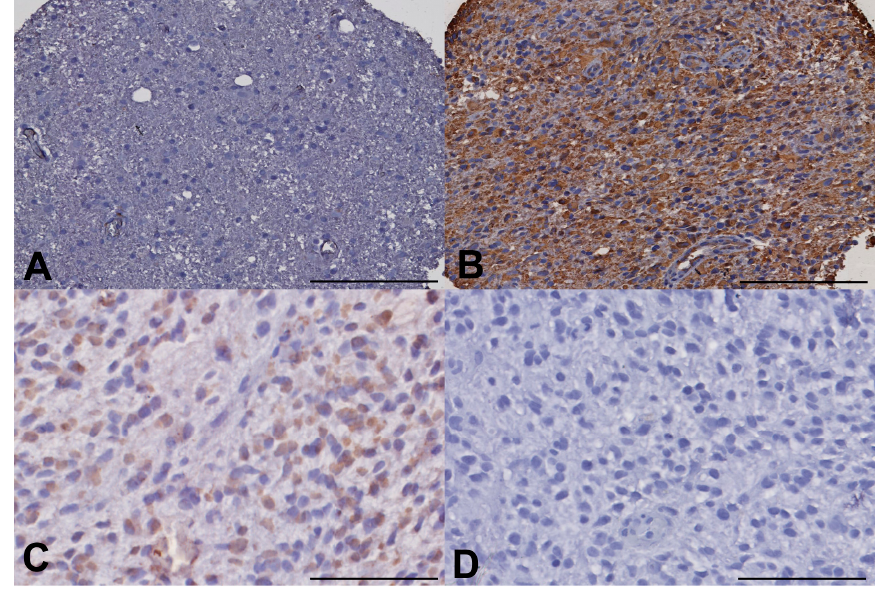
Figure 4. The GBM invasive margin exhibits reduced expression of canonical glioma stem cell markers. ( A ) Immunohistochemistry against nestin in invasive zone tissue showing low staining (23.1% +/ − 11%). ( B ) Immunohistochemistry against core tumour showing high expression of nestin (80.7% +/ − 31%). ( C ) Positive staining for ALDH1 in an invasive region of tumour (53.6% +/ − 29%). ( D ) Low levels of ALDH1 detected in the tumour core (10.3% +/ − 4%). ( A , B ) ×40, ( C , D ) ×200. Error bars ( A , B ) 100 µm; ( C , D ) 25 µm.